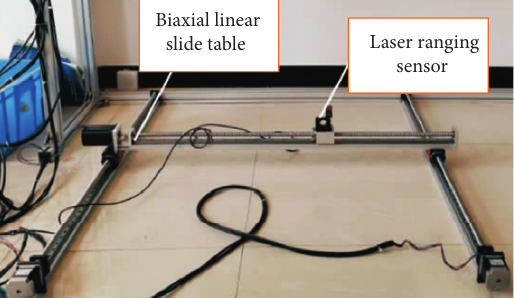
Figure 13: Roadway surface profile measurement platform.